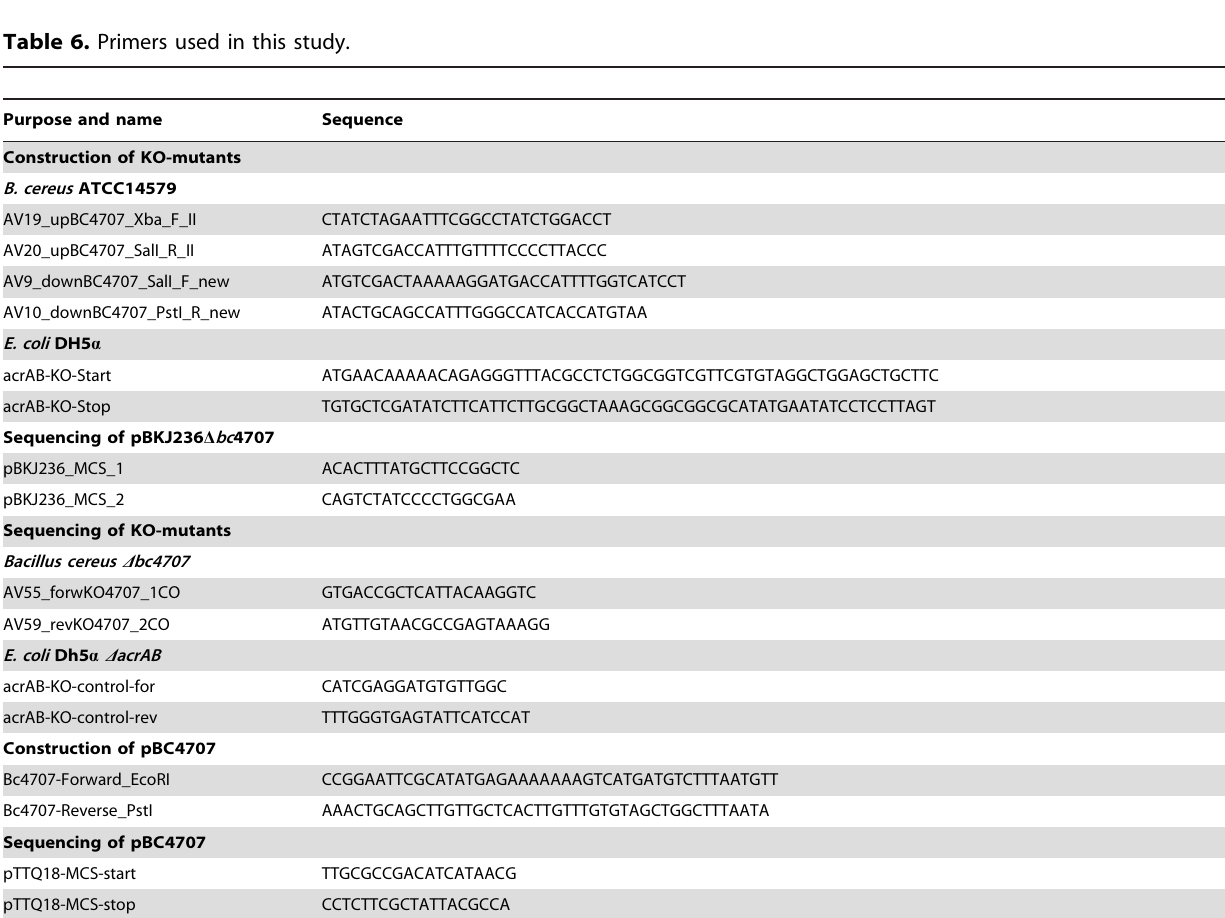
Table 6. Primers used in this